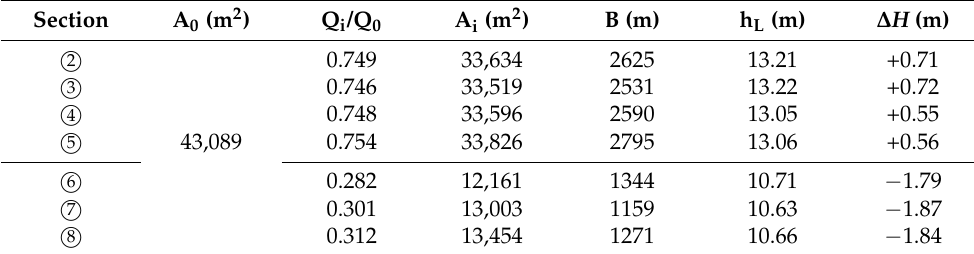
Table 4. Equilibrium water depth of the Fujiangsha Waterway after the project.